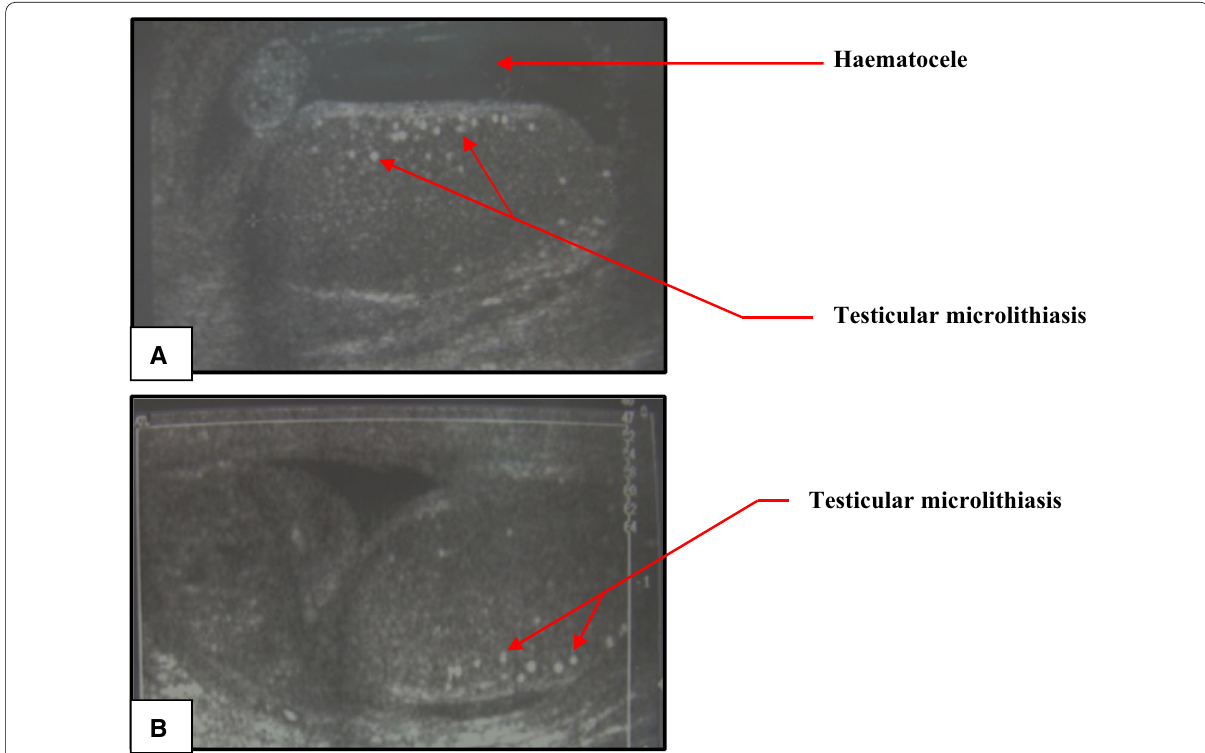
Fig. 1 A and B Echographic image showing bilateral TMs and hematocele on the right